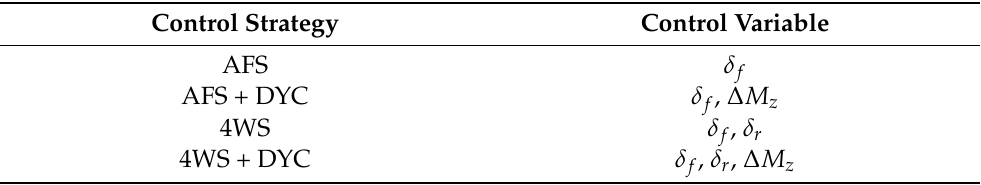
Table 3. Control Strategies of 4WID-4WIS